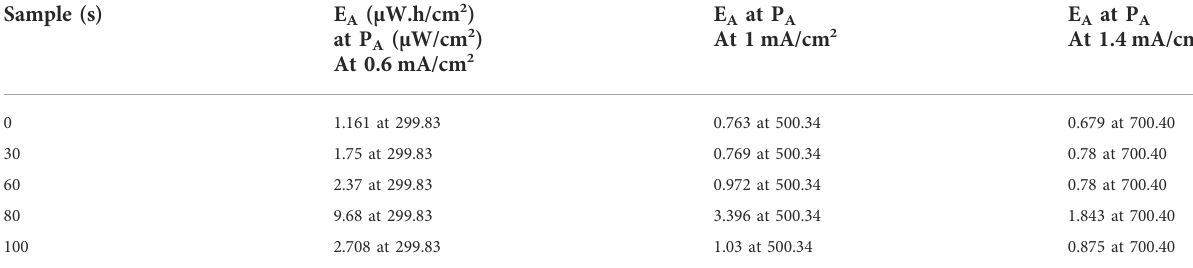
TABLE 1 The calculated energy and power density for current density are 0.6, 1.0, and 1.4 mA/cm 2